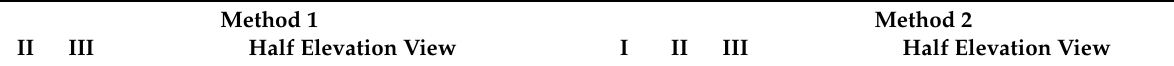
Figure 2. Crossed ‐ cable model details.